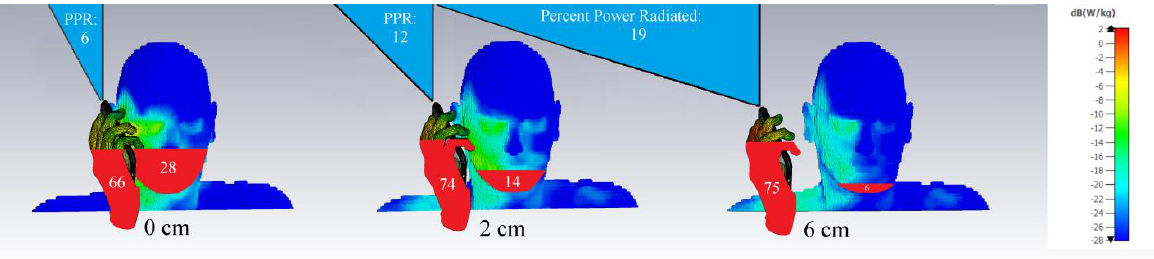
Figure 7. When including the hand holding the phone in psSAR simulations, the 0 cm position (touch) results in 66% of the power being absorbed by the hand (PPHand), 28% by the head (PPHead) for a total absorption of 94% in the body, PPB), and 6% (PPR) radiated for communication. At 2 cm, PPHand is 74%, PPHead is 14%, and PPR is 12%. At 6 cm, PPHand is 75%, PPHead is 6%, and PPR is 19%. The frequency of operation is 900 MHz, and the power delivered to a planar Inverted-F Antenna is 250 mW.